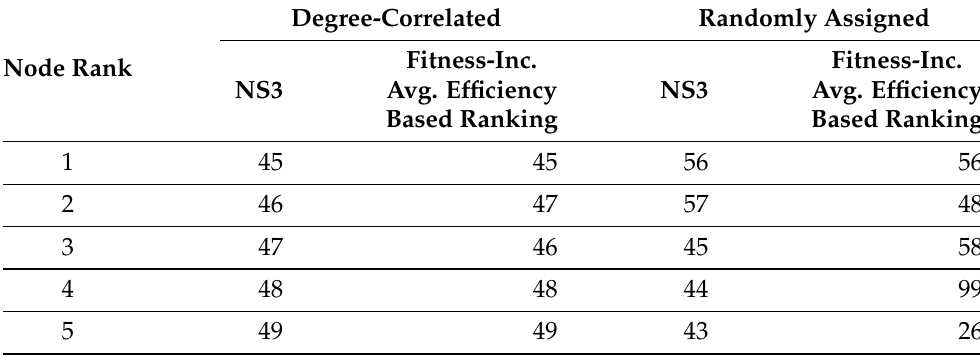
Table 4. Node ranking comparison in the random topology (presented with Node IDs), based on fitness-incorporated average efficiency, when the node fitness is distributed in a degree-correlated and a random manner.